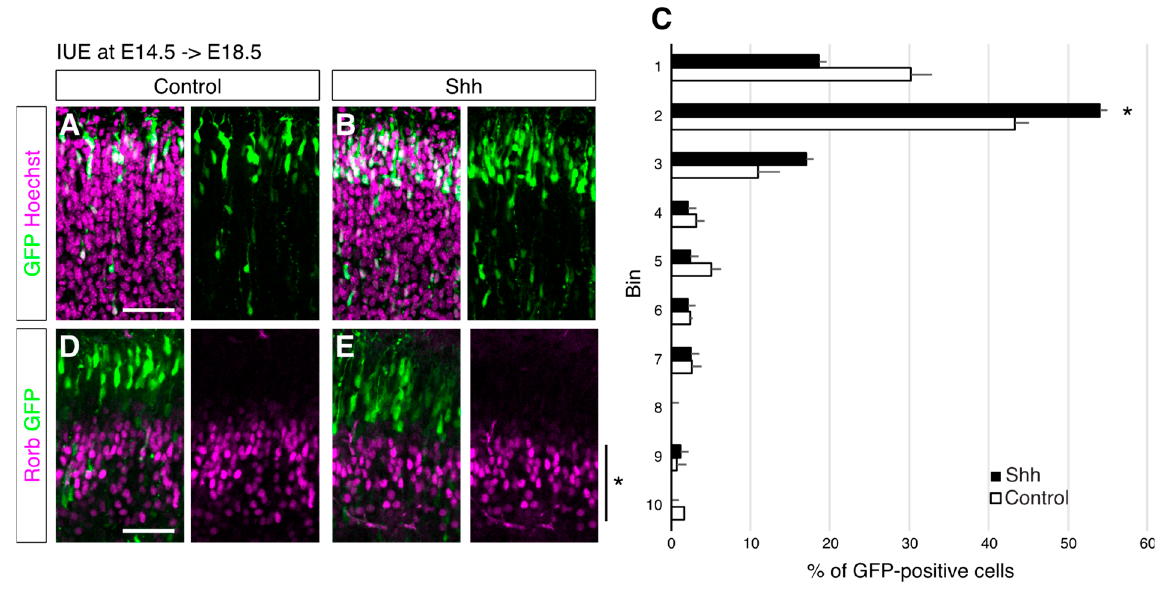
Figure 4. Upregulated Shh signaling regulates cell positioning without affecting an L4 marker expression. Empty (Control) or Shh expression vector (Shh) together with a GFP vector was electroporated into E14.5 brains, and then E18.5 brains were analyzed. The sections were counterstained with Hoechst ( A , B ) or immunostained for Rorb ( D , E ). The asterisk shows expression of Rorb in developing L5 neurons [16]. ( C ). Quantitative data of cell positioning are presented. The position of each GFP-positive cell relative to the total distance from the bottom of the subplate to the outer edge of the cortical plate was measured, followed by sorting into 10 bins ( n = 4 for each group). * p < 0.05. (Scale bars: 200 µm in ( A , D )).